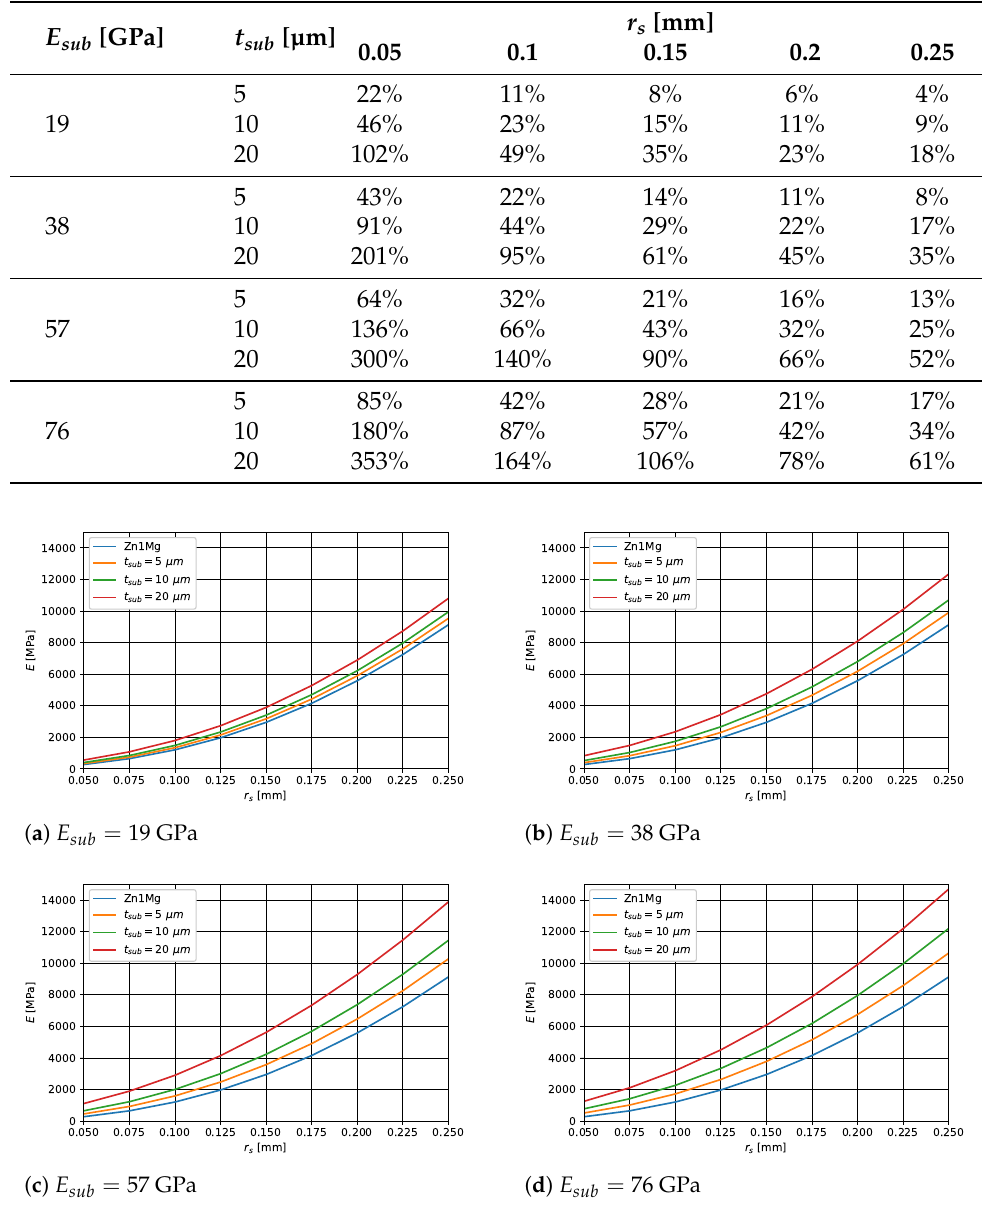
Table 2. Percentage increase of the smeared Young’s modulus E for varying substrate Young’s moduli E sub and layer thicknesses t sub .